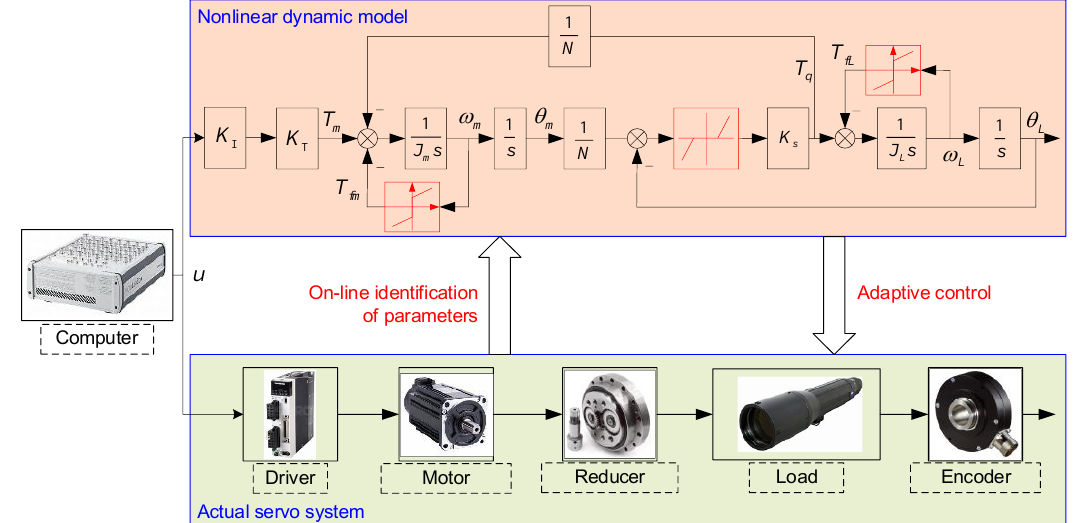
Figure 2. Nonlinear dynamic model framework.